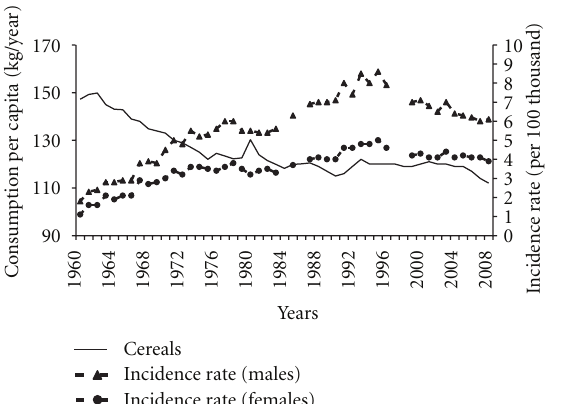
Figure 12: Alcohol consumption and pancreatic cancer morbidity 1960–2008.